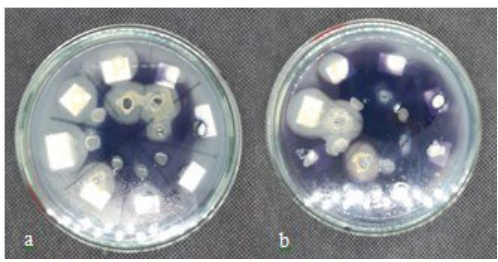
Fig. 5. Macroscopic observation of isolate DU4.2 (a) and isolate DU4.22 (b), and microscopic observation of isolate DU4.2 (c) and isolate DU4.22